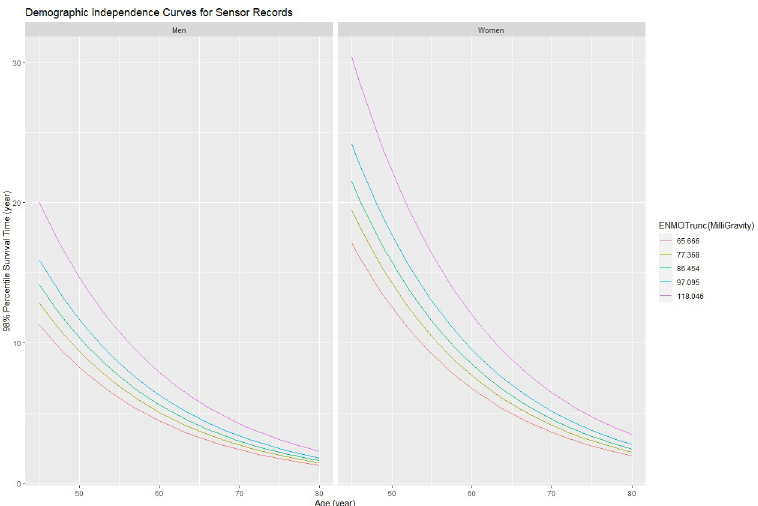
Fig 5. Demographic independence curves for sensor records. Acceleration magnitude (ENMOtrunc) independent predictor against Age and Sex.